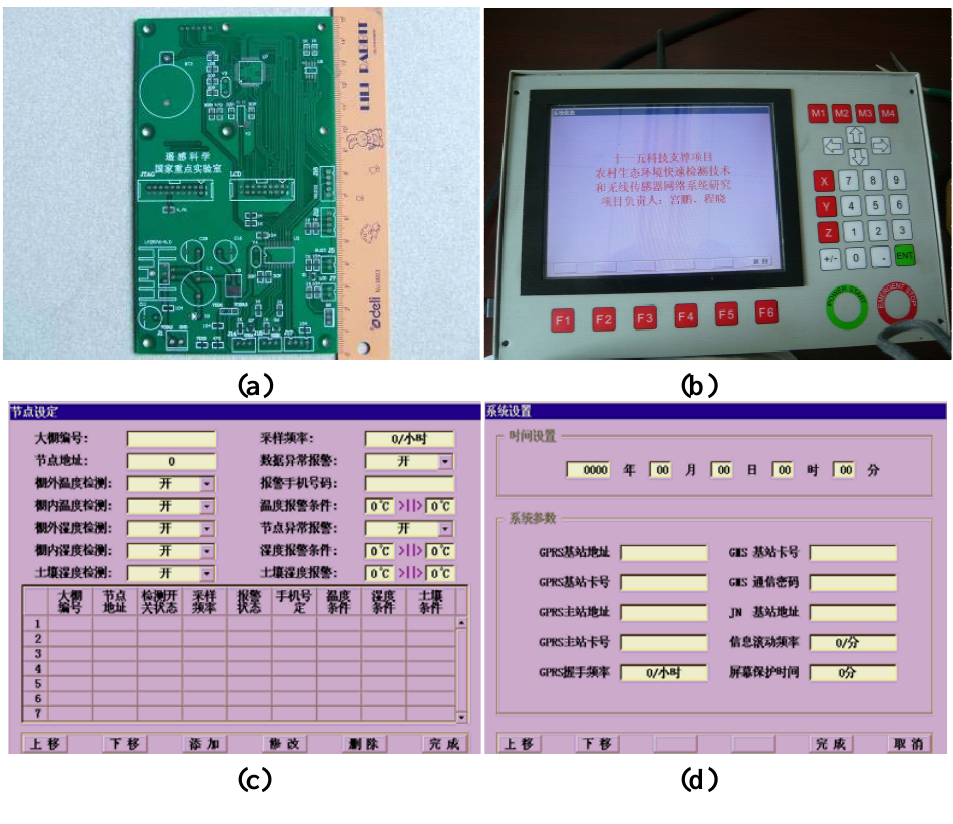
Figure 9. Control configuration page of base station. (a) mainboard of base station; (b) the base-station system with LCD display, keyboard and wireless transceiver module; (c) interface of node configuration; (d) interface of system